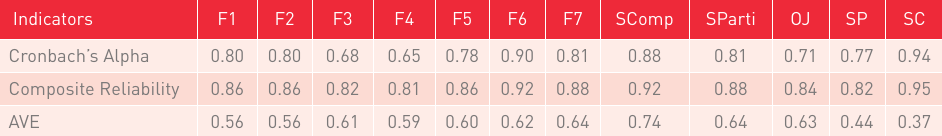
Structural Model indices in PLS-SEM